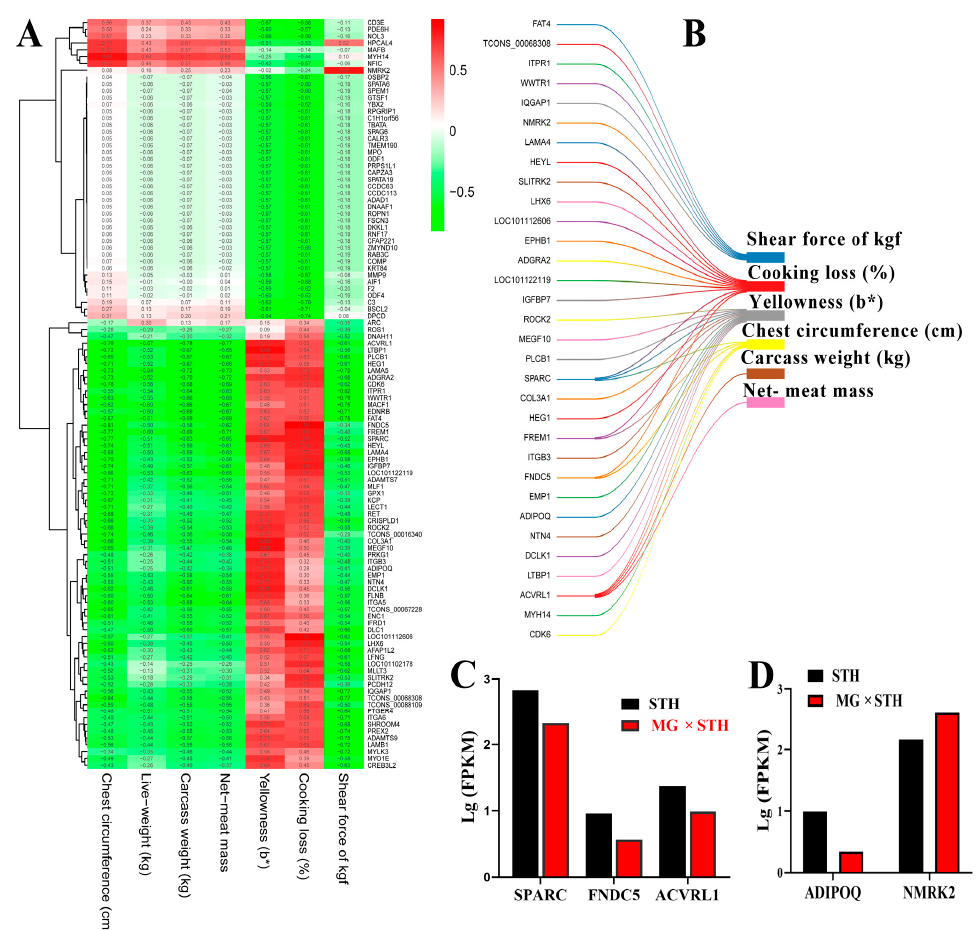
Figure 4. A correlation analysis between DEGs and production performance and meat quality traits. ( A ) A heatmap of the gene–trait relationship established according to the Pearson correlation of DEGs and significantly different production performance and meat quality traits. ( B ) A Sankey diagram created with Pearson correlation coefficient thresholds >0.75 or < − 0.75. ( C,D ) The relative expression of five candidate DEGs from RNA-seq data, where the expression value was calculated according to the log(FPKMs). FPKMs: Fragments per kilobase million.